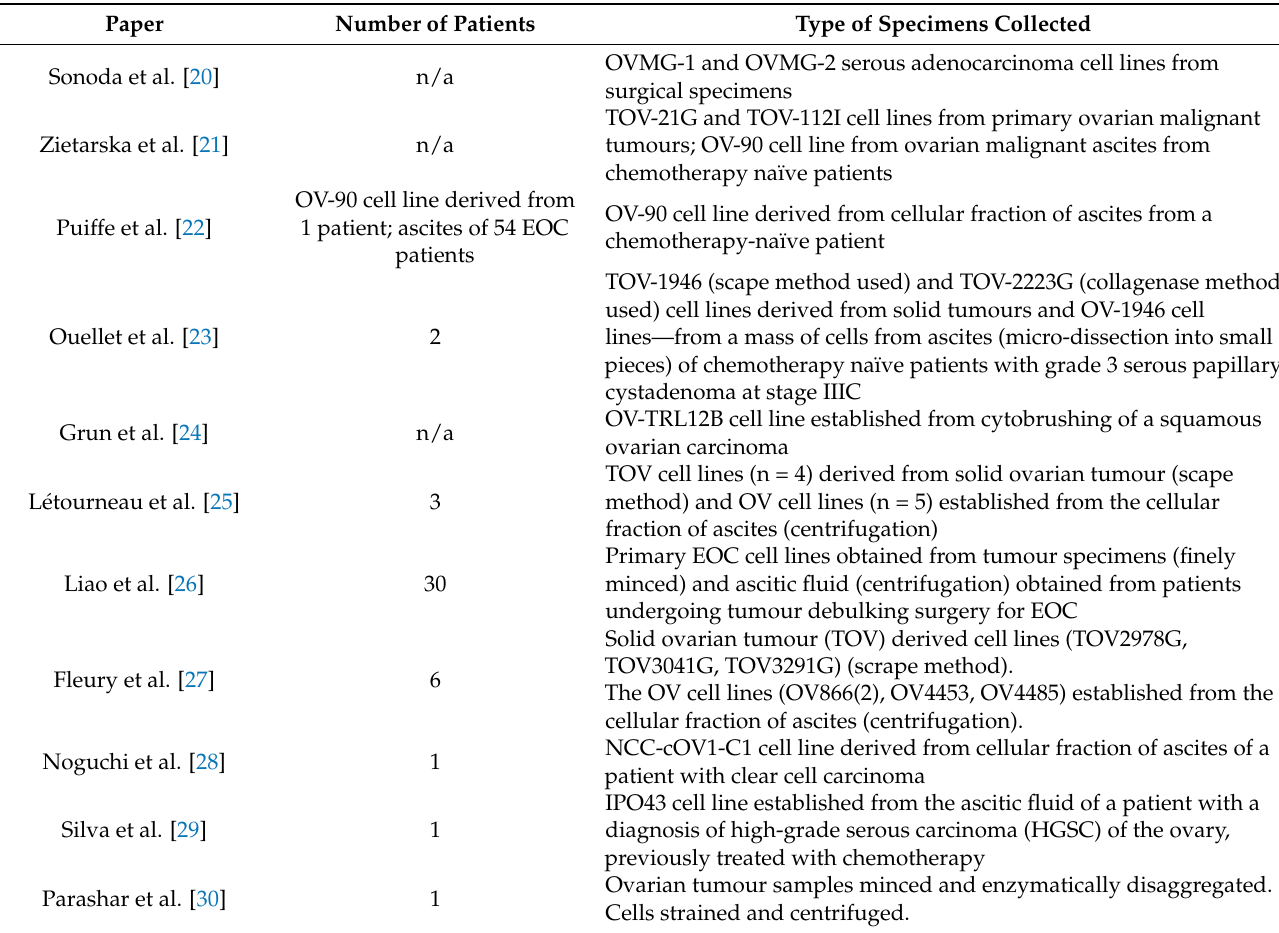
Table 3. Summary of papers, which used cell lines derived directly from primary patient specimens to develop spheroid